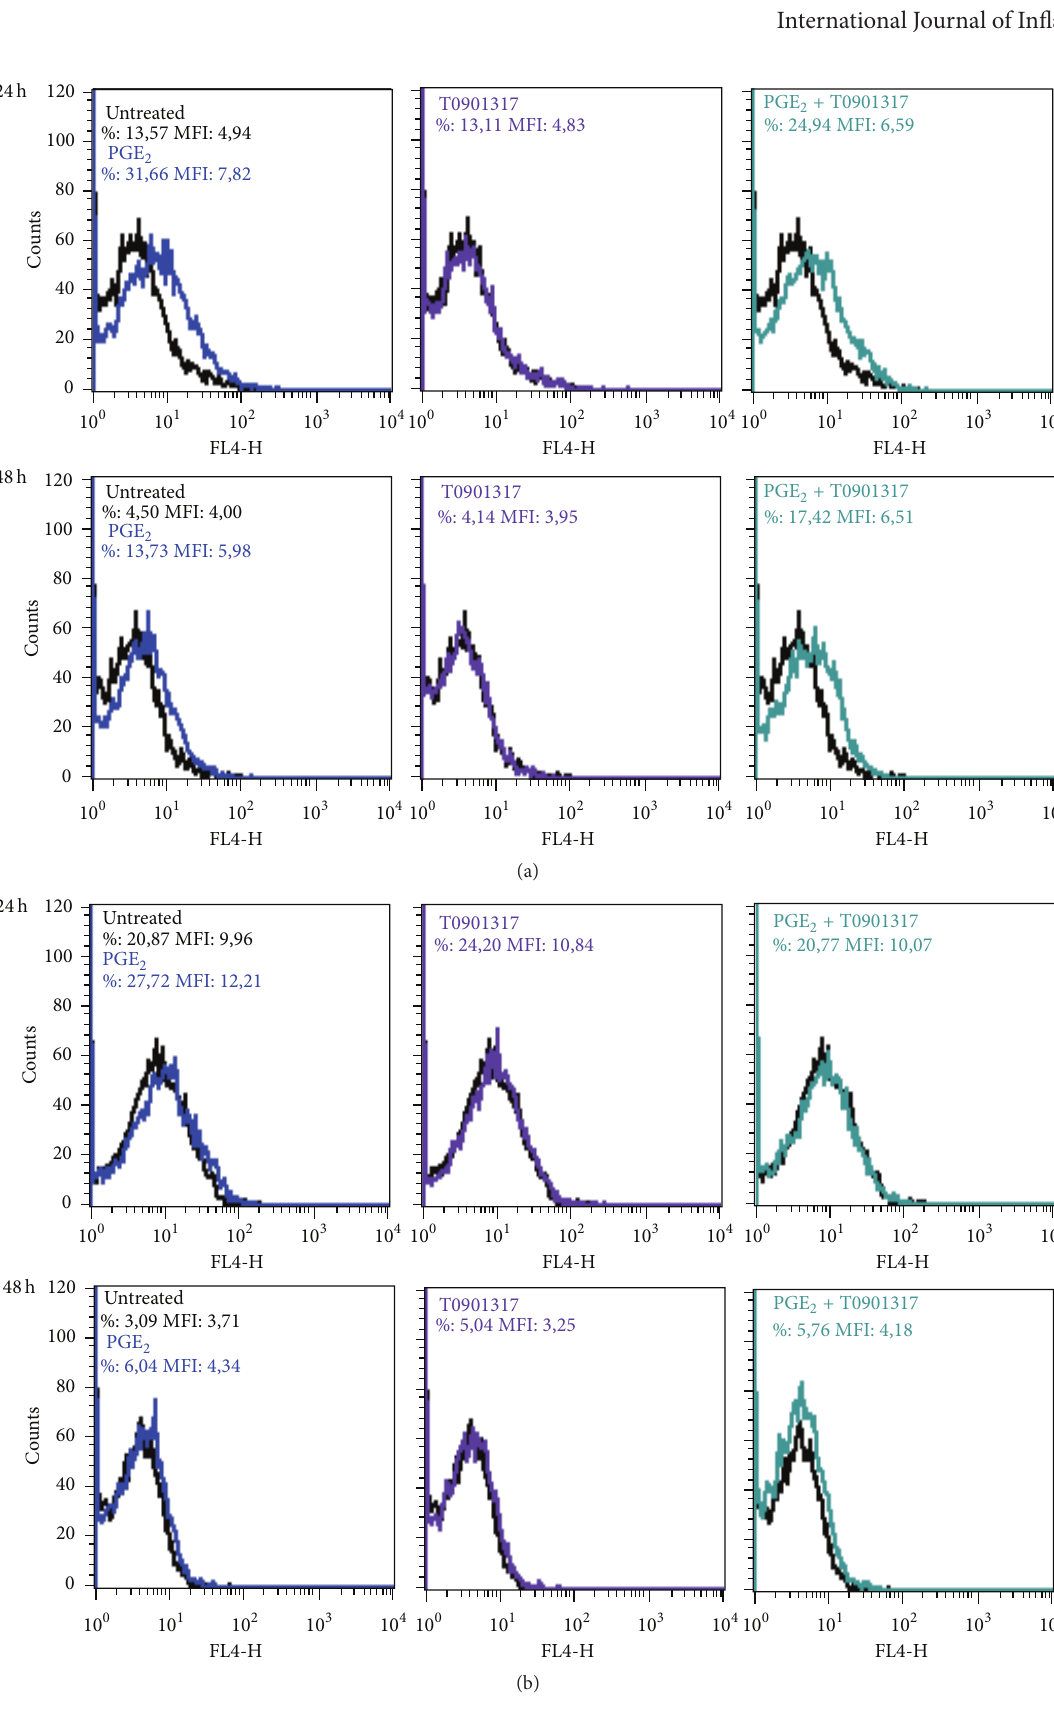
Figure 4: Cell surface and intracellular expression of CCR7 in MM-1 cells. CCR7 surface expression (a) or intracellular expression (b) was evaluated by flow cytometry after treatment with 1 𝜇 M PGE 2 and/or 1 𝜇 M T0901317 for 24 h or 48h. Data shown are from one of three representative